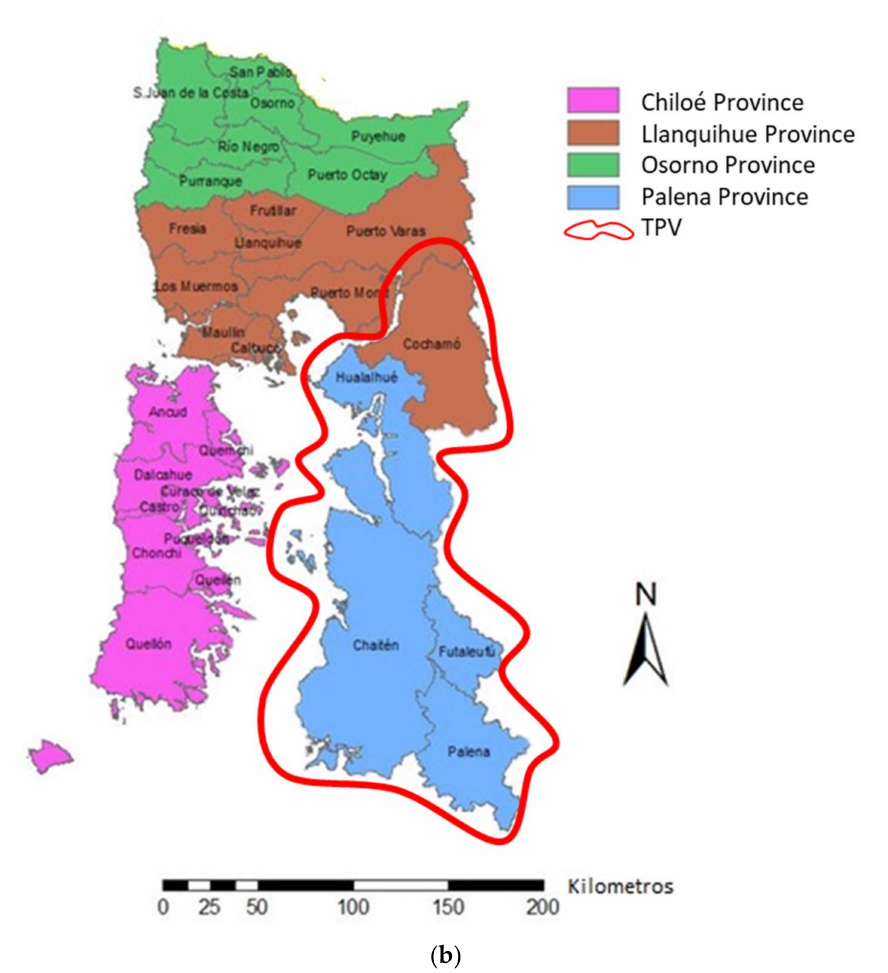
Figure 1. ( a ) Map of Chile (each number represents a sampling zone). ( b ) Political map of the Los Lagos region, showing the provinces. TVP is outlined in red, it includes the whole Palena province its four districts (Chait é n, Futaleuf ú , Hualaihu é , and Palena) and the Cocham ó district in the Llanquihue